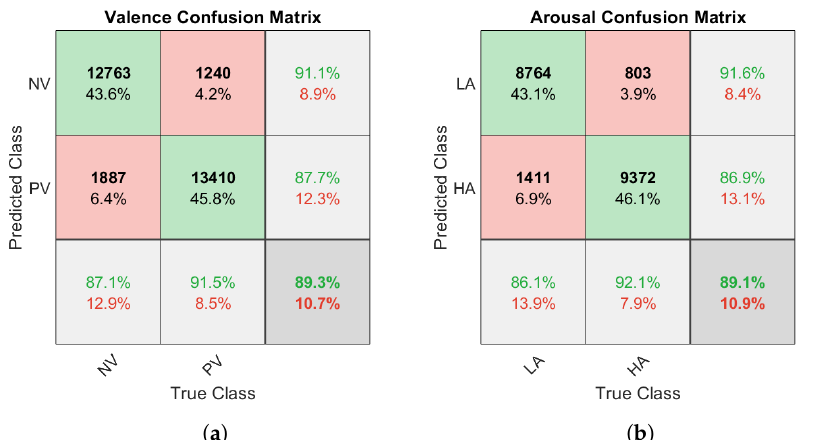
Figure 5. Confusion matrix for the Ensemble Bagged Tree classifier in the valence ( a ) and arousal ( b ) dimensions.